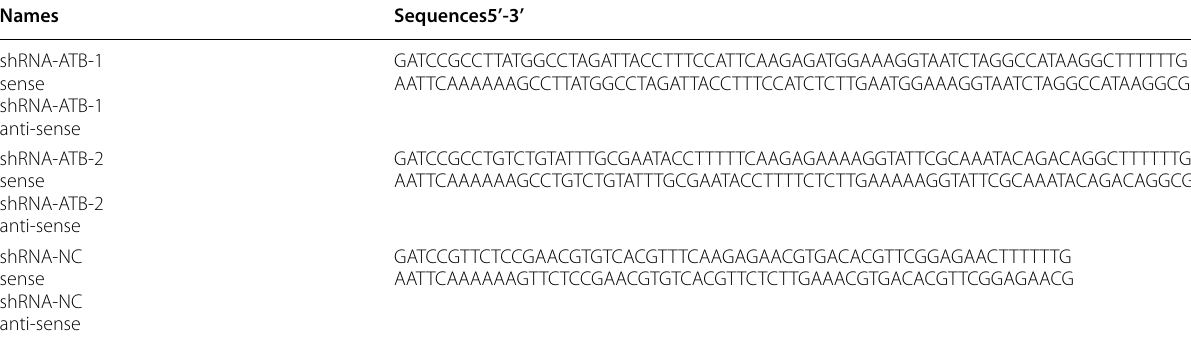
Table 1 Primers used for shRNAs sequences Names